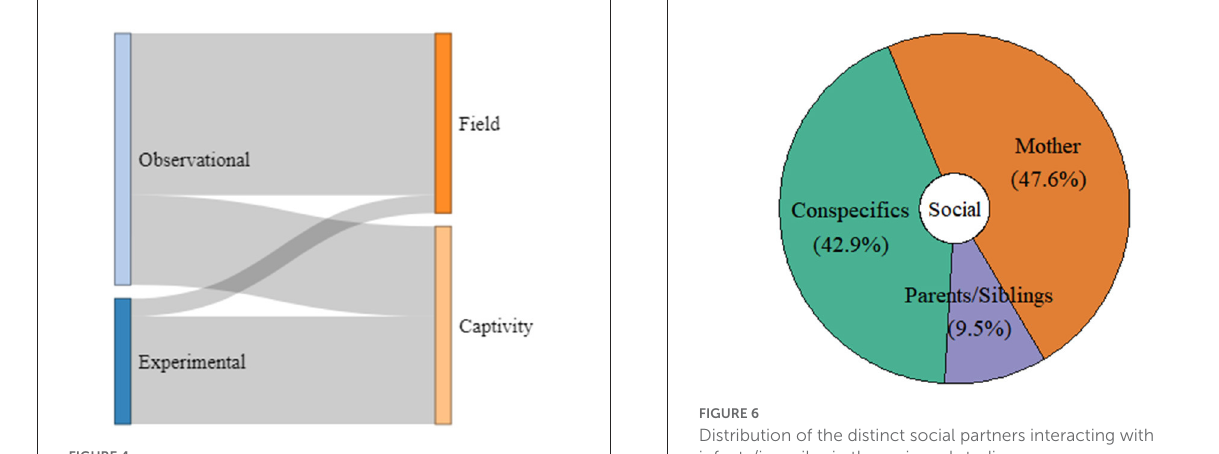
FIGURE4 Distribution of research designs employed in the reviewed studies.